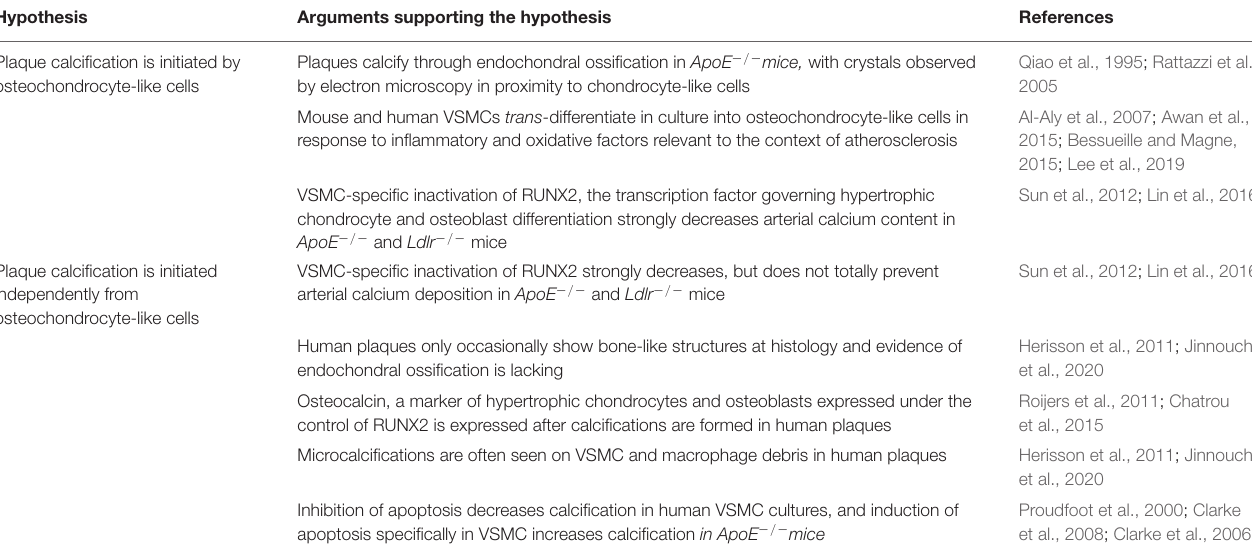
TABLE 1 | Arguments in favor of, and arguments against the hypothesis that calcification is initiated by osteochondrocyte-like cells.